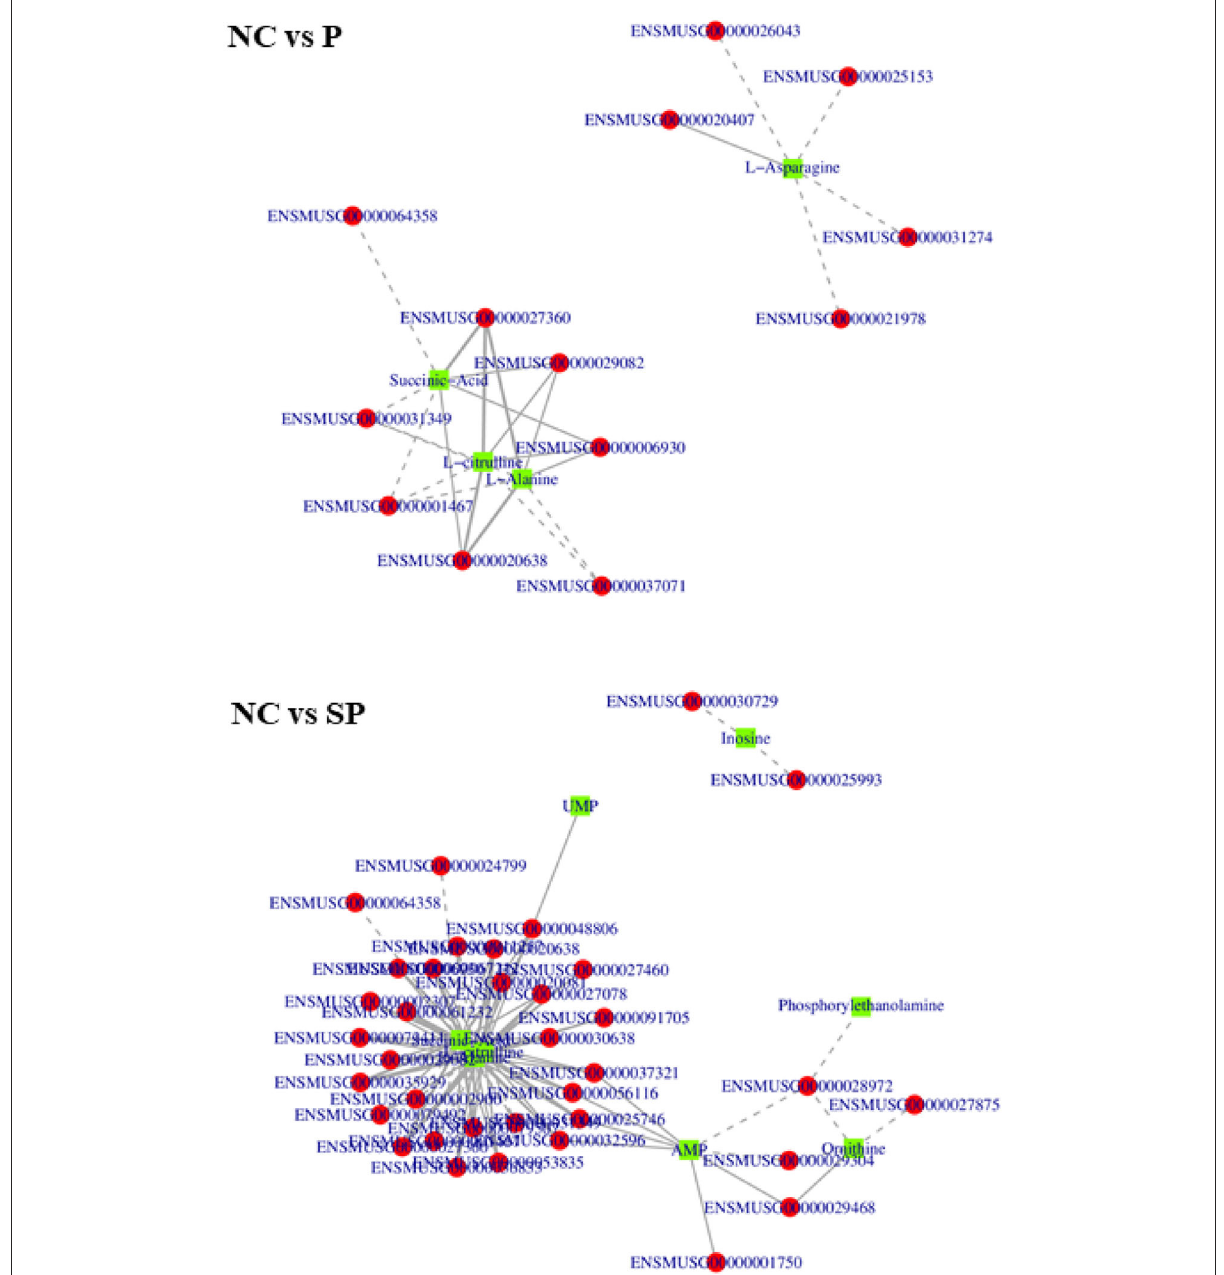
FIGURE10 Correlation network diagrams of differential expressed genes and differential metabolites. The squares in the figure represent the differential metabolites, the circles represent the differential genes, the solid line represents the positive correlation, the dashed line represents the negative